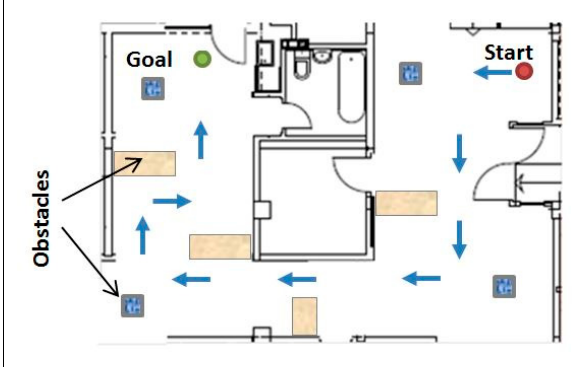
Figure 8. Evaluation environment for the navigation scenario.